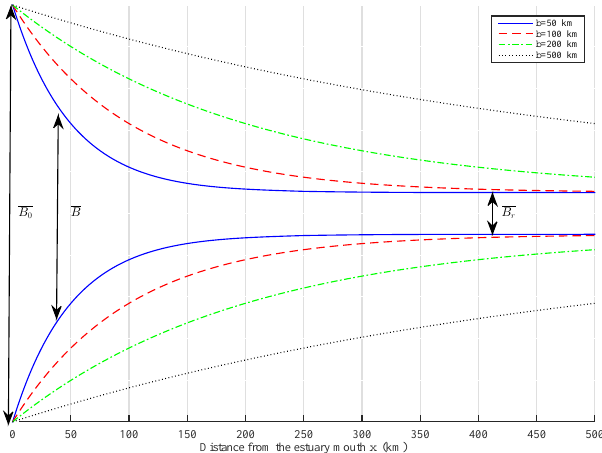
Figure 1. Variation of the estuarine shape (Eq. 2) under different width convergence length b for given values of B 0 = 10km and B r =